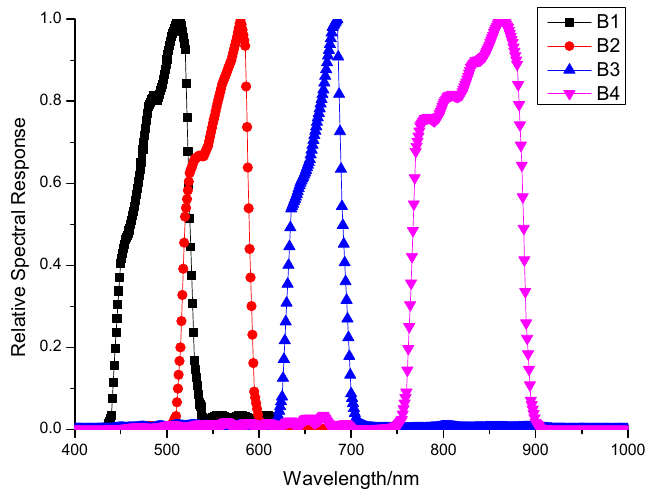
Figure 3. Relative spectral response of PRSS-1 multispectral camera.